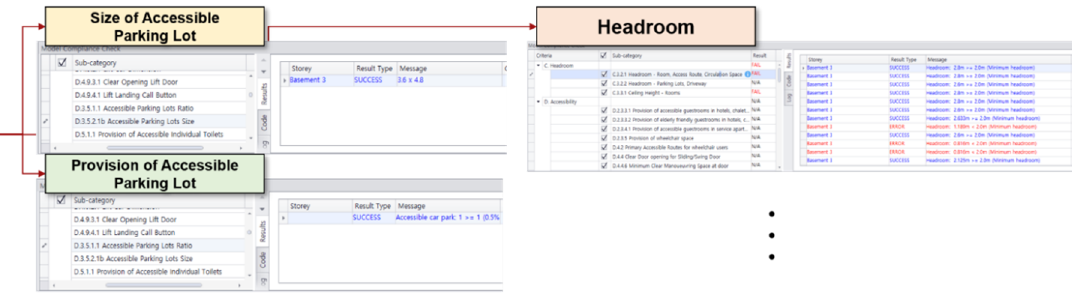
Figure 9. Review of BIM-based parking lot licensing laws (SBim Assess) for the licensing.